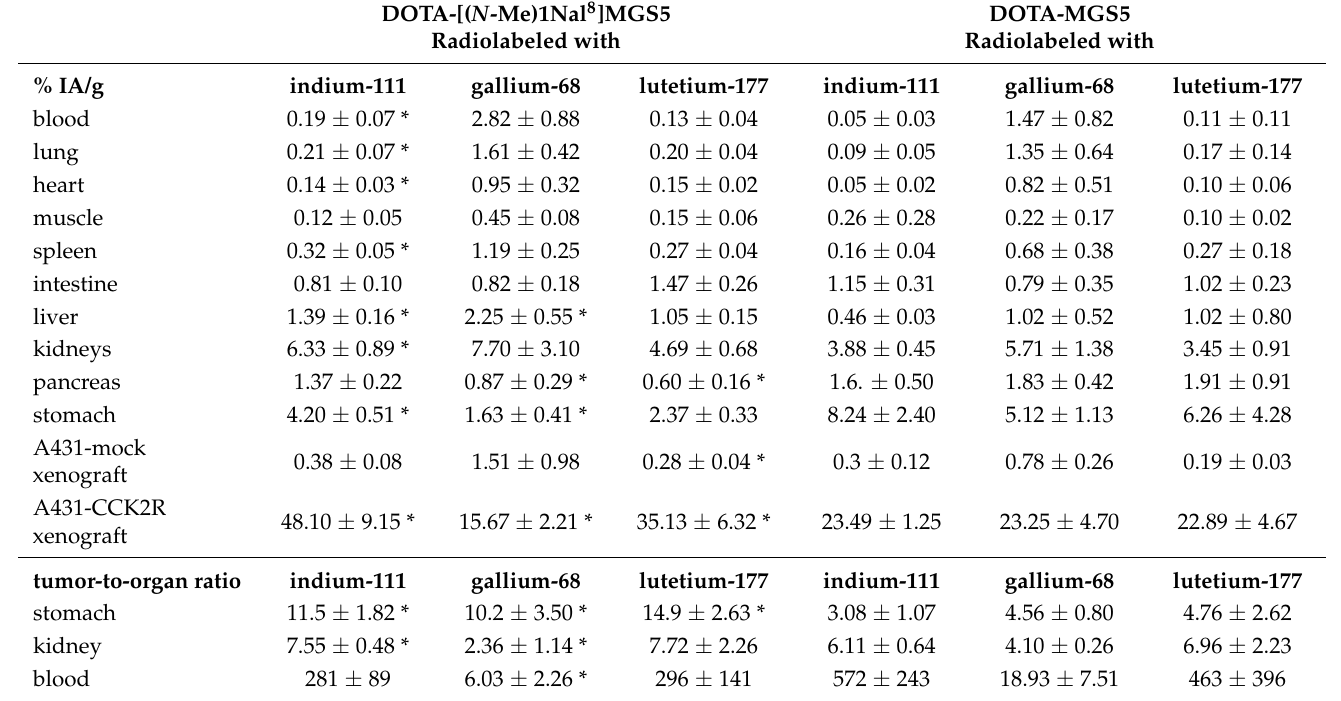
* statistically significant ( p ≤ 0.05) when compared to the DOTA-MGS5 counterpart. The non-specific uptake in A431-mock xenografts (tumor weight: 0.18 ± 0.13 g, n = 24) was below 1% IA/g for all peptide derivatives labeled with indium-111 and